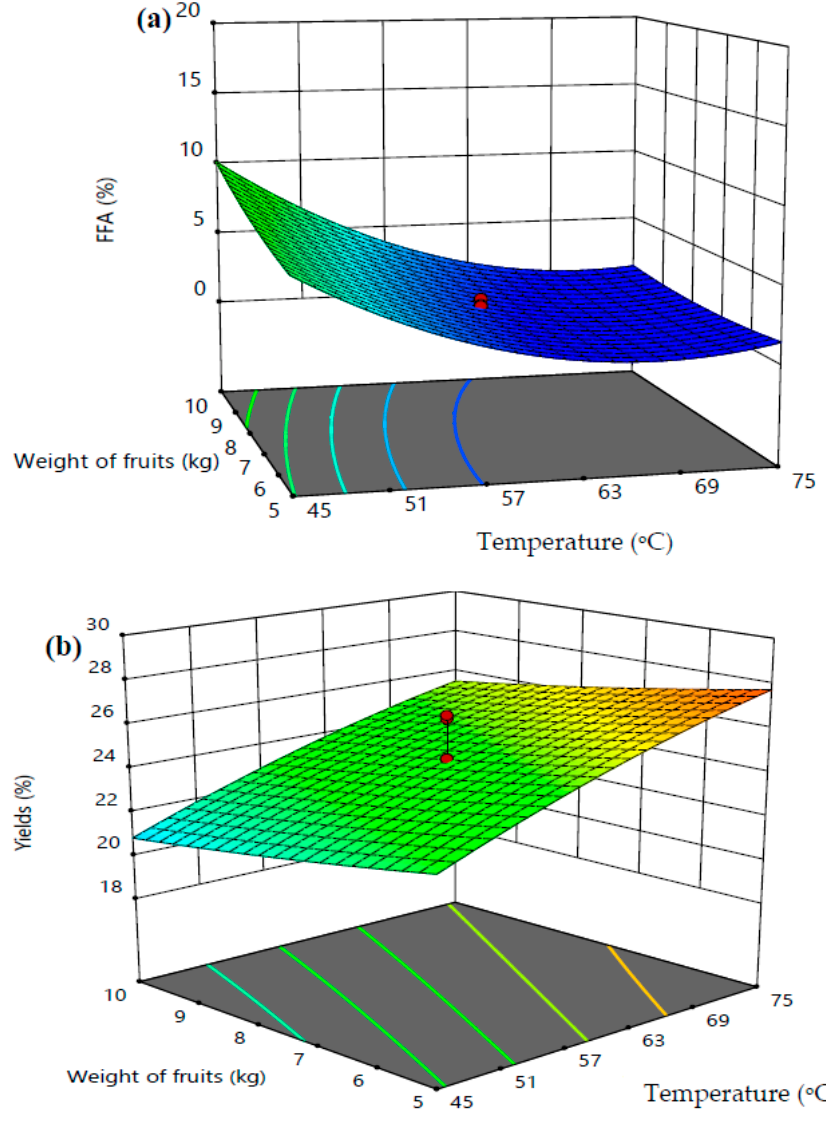
Figure 6. Interaction effects between the cold-pressed sterilization temperature and weight of palm fruits on FFAs in cold-pressed VPO ( a ) and VPO yield ( b ).